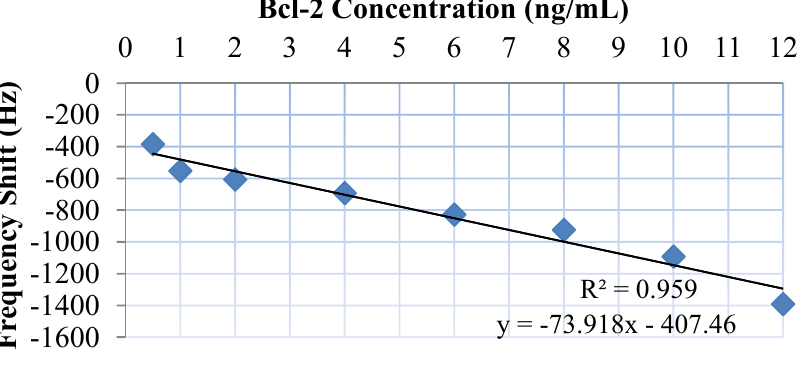
Figure 10. Average frequency shift measured, corresponding to different Bcl-2 concentrations and best line fit (R 2 =